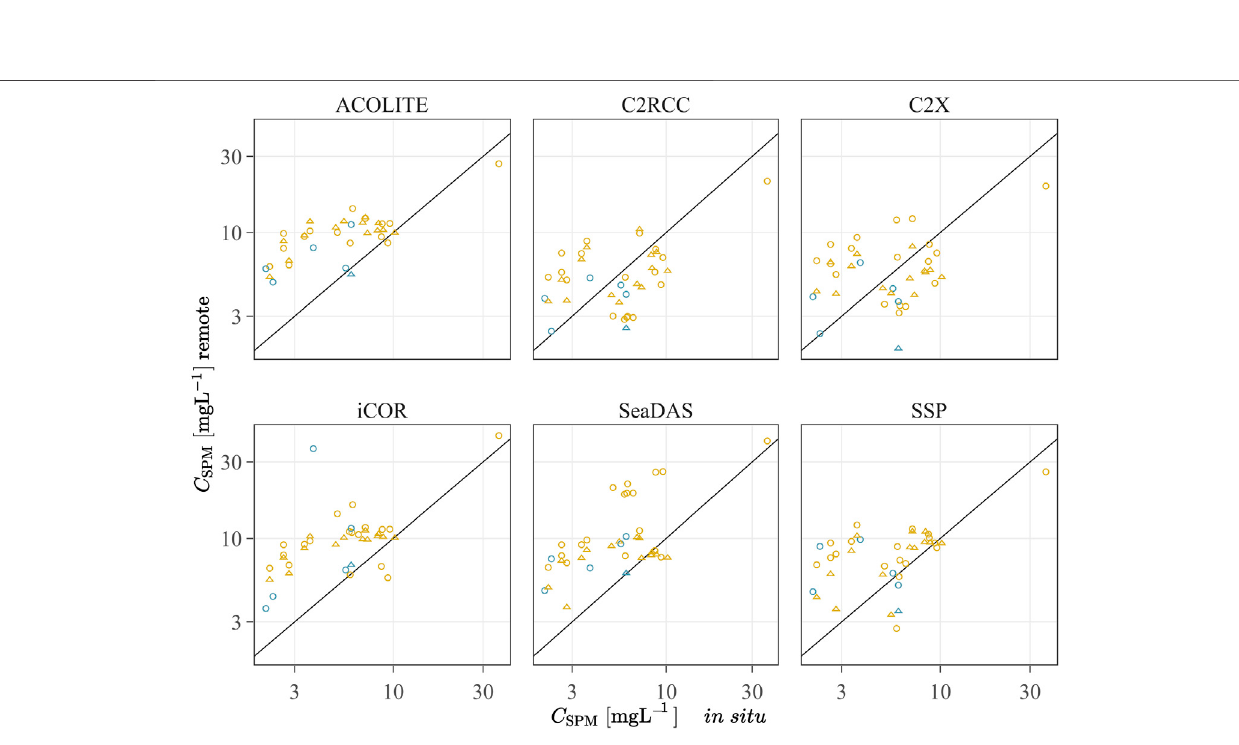
Frontiers in Remote Sensing |